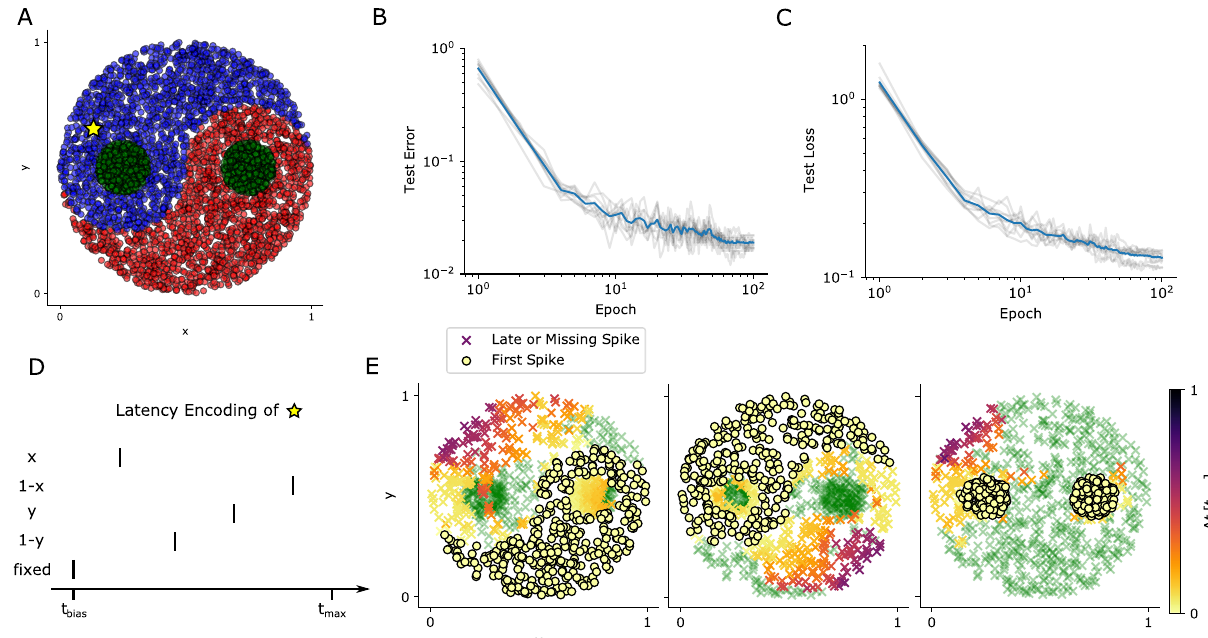
Figure 3. We used EventProp and a time-to-first-spike loss function to train a two-layer leaky integrate- and-fire network on the Yin-Yang dataset. ( A ) Illustration of the two-dimensional training dataset. The three different classes are shown in red, green and blue. This dataset was encoded using spike time latencies (see D ). ( B, C ) Training results in terms of test error and loss averaged over 10 different random seeds (individual traces shown as grey lines). ( D ) Data points ( x , y ) were transformed into ( x , 1 − x , y , 1 − y ) and encoded using spike time latencies. We added a fixed spike at time t bias . ( E ) Spike time latencies (cid:31) t of the three output neurons (encoding the blue, red or green class) after training, for all samples in the test set and a specific random seed. Latencies are relative to the first spike among the three neurons and given in units of t max . A latency of zero (bright yellow dots) implies that the corresponding neuron fired the first spike, determining the class assignment. Missing spikes are denoted using green